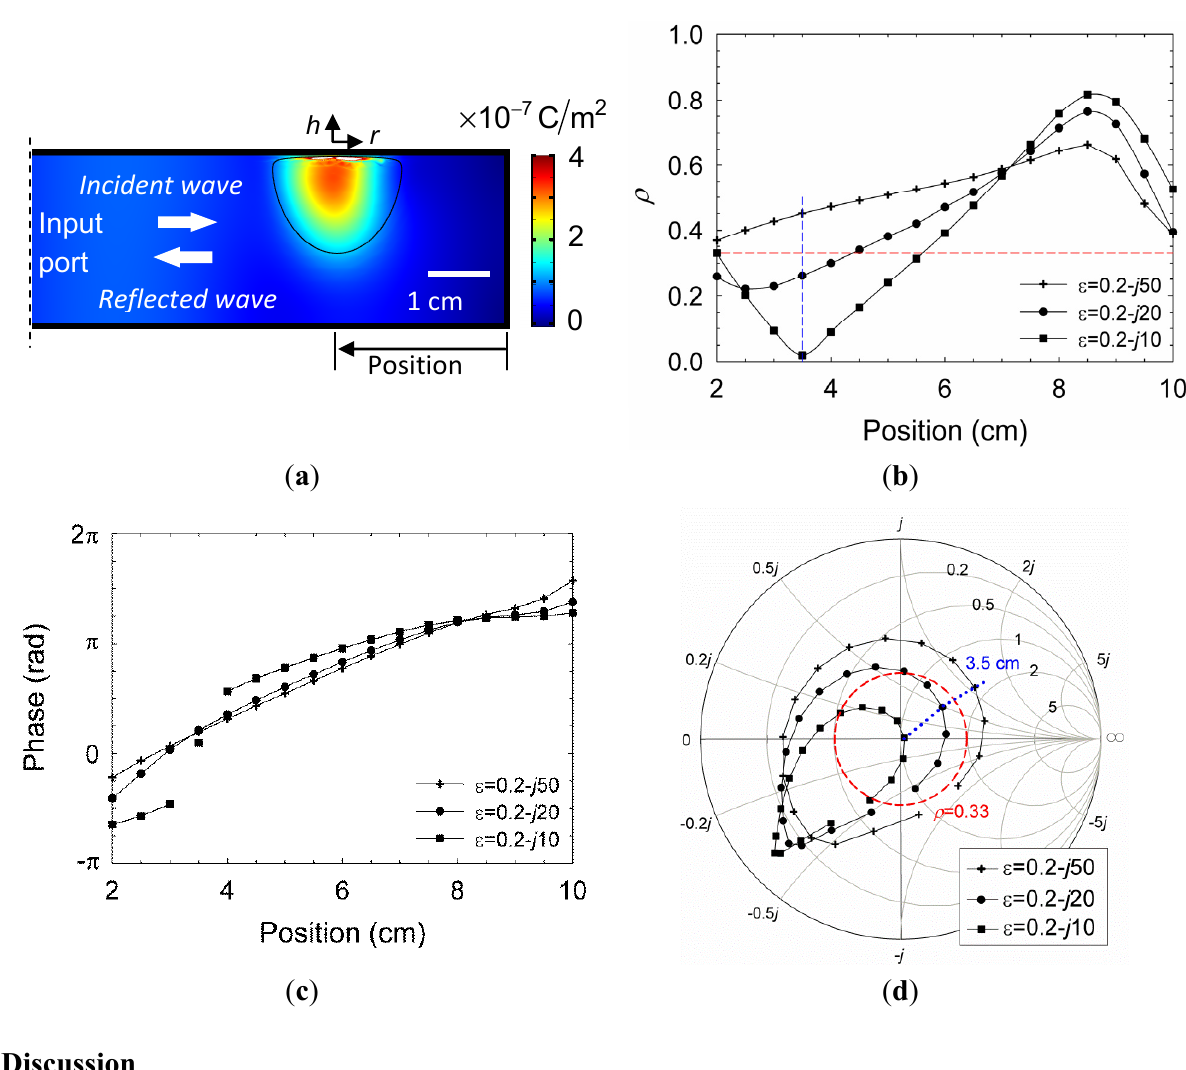
Figure 13. A parametric estimation of the dusty plasmoid properties by the microwave reflection measurements: ( a ) The plasmoid shape and position used in the numerical model presented by the amplitude profile of the displacement field for ε = 0.2 − j 20; ( b,c ) The r amplitude and phase, respectively, of the reflection coefficient as a function of the plasmoid position, for various values of ε ; and ( d ) A Smith-chart presentation for the r plasmoid’s impedance. The dashed Red circle indicates the self-impedance matching region ( 0.33 Γ ≤ ) as observed experimentally in Figure 3b. The dotted Blue curve marks the 35 mm position at which a perfect match is obtained for ε = 0.2 – j r